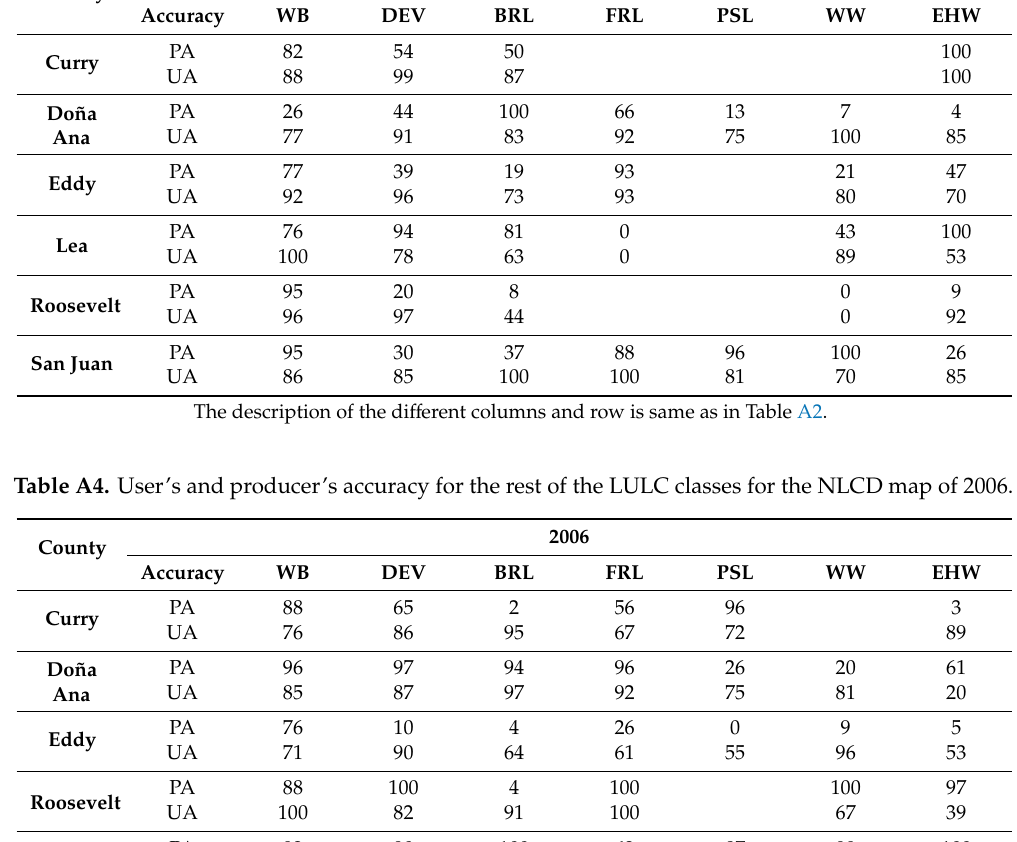
Table A3. User’s and producer’s accuracy for the rest of the LULC classes for the NLCD map of 2001. County